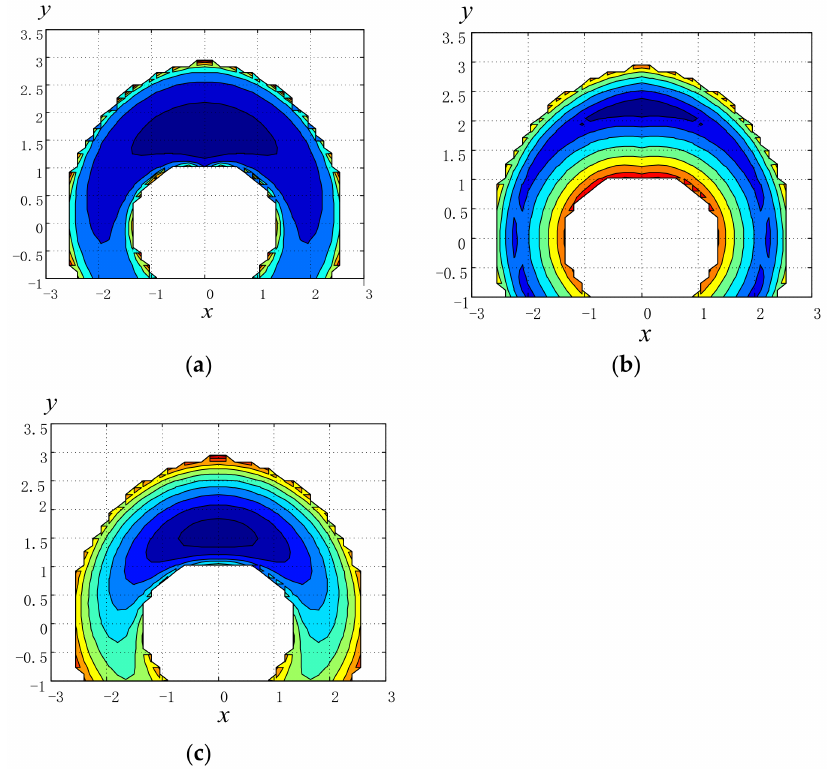
Figure 6. Contours of κ and of the maximum ITA and CTA in bounded workspace. ( a ) Contours of κ ; ( b ) contours of ITA— α max = max ( α 1 α 2 ) ; ( c ) contours of CTA in workspace bounded by κ 0 =